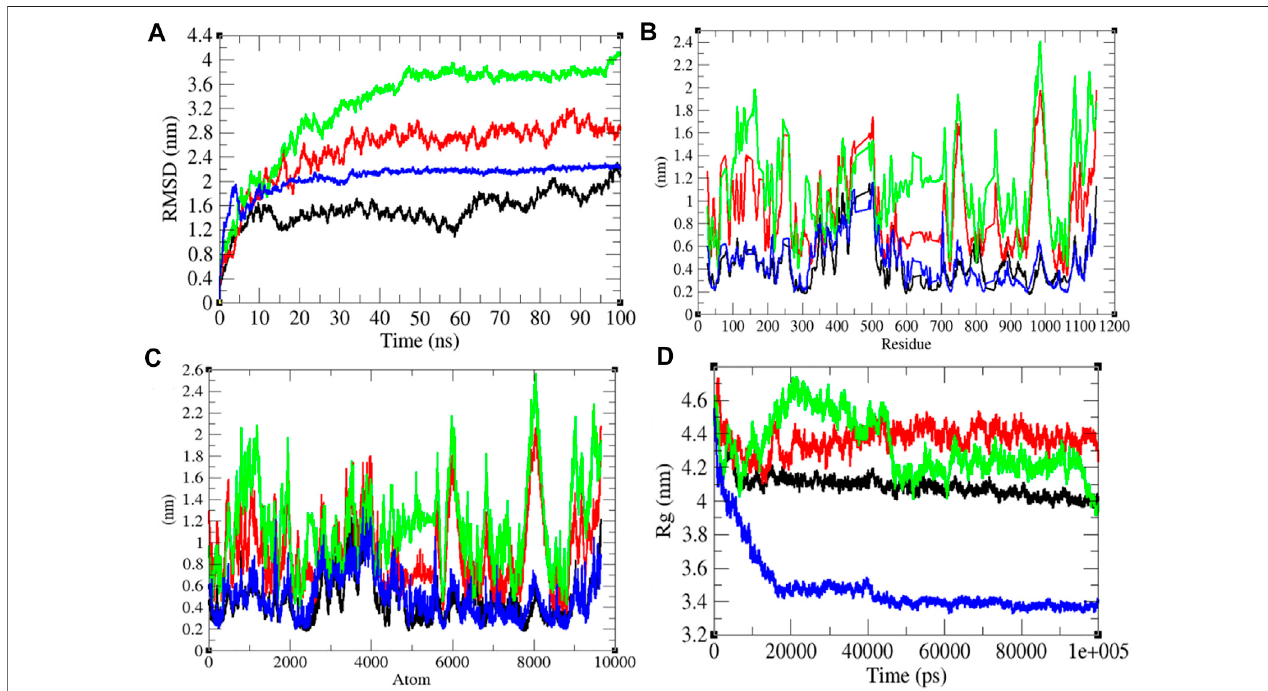
FIGURE 2 | Structural dynamics. (A) RMSD plot for the SARS-CoV-2 S protein vs. time. (B) RMSF vs. residues. (C) RMSF vs. residues. (D) R g plot vs. time. The values calculated at 0 ° C (black), 20 ° C (red), 40 ° C (green), and 60 ° C (blue), respectively.